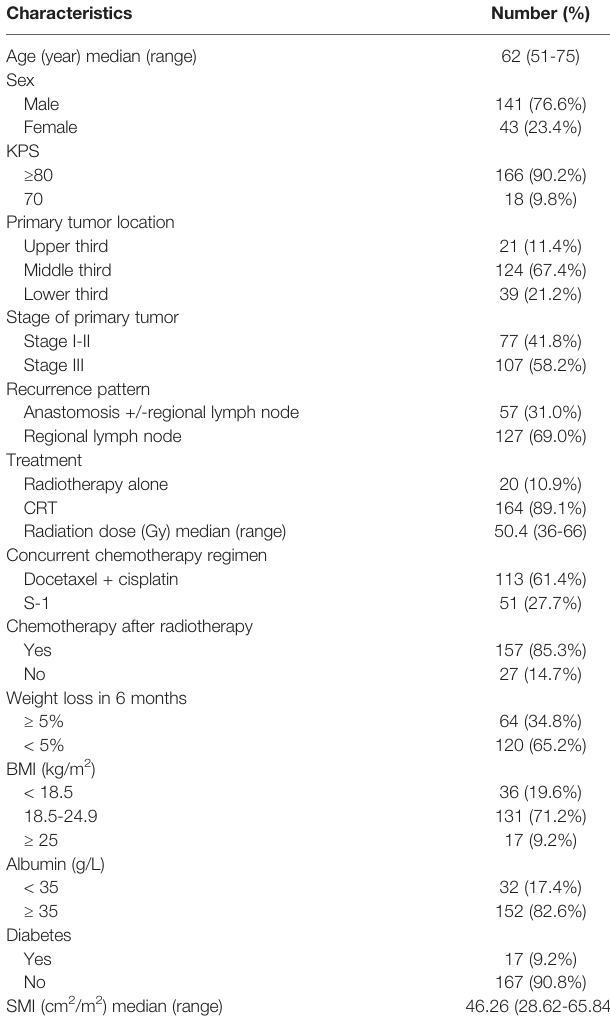
TABLE 1 | Patient and treatment